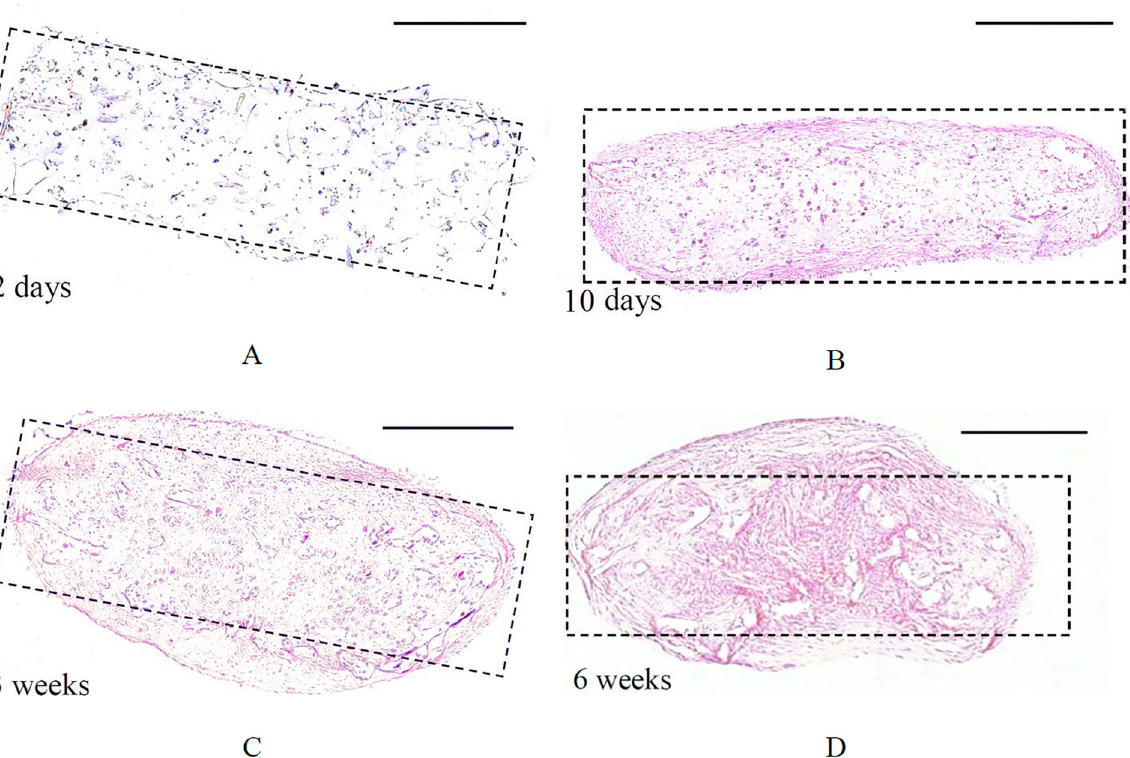
Fig 9. Hematoxylin and eosin staining of high aspect TE strips cultured for 2 days (A), 10 days (B), 3 weeks (C) and 6 weeks (D). The scale bar represents 500 μ m. By extending culture time, TE strips became more compacted. Dashed rectangles represent the original shape of the strips.